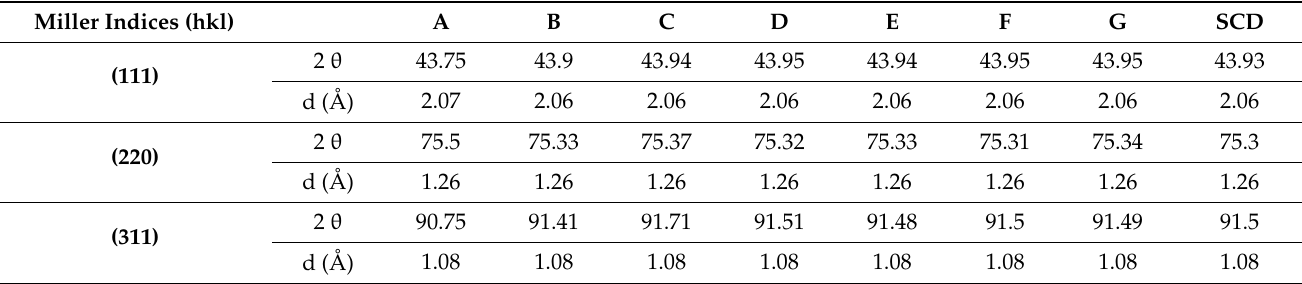
Table 2. Calculation of d-spacing for (hkl) planes for samples A–G compared with a single crystal diamond (SCD). Miller Indices